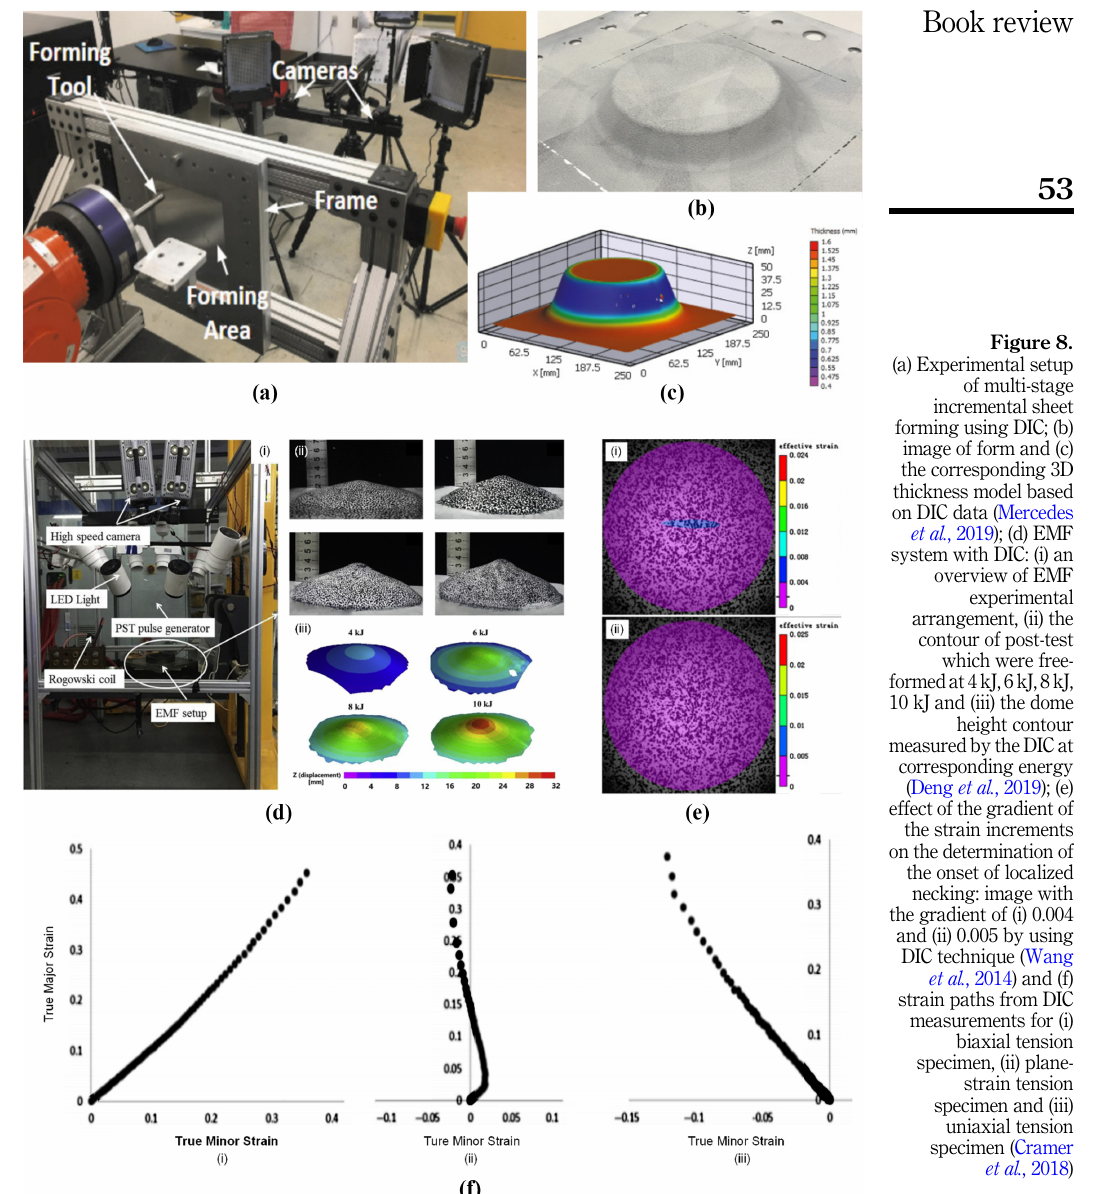
Figure 8. (a) Experimental setup of multi-stage incremental sheet forming using DIC; (b) image of form and (c) the corresponding 3D thickness model based on DIC data (Mercedes et al. , 2019); (d) EMF system with DIC: (i) an overview of EMF experimental arrangement, (ii) the contour of post-test which were free- formedat4kJ,6kJ,8kJ, 10 kJ and (iii) the dome height contour measuredby the DIC at corresponding energy (Deng et al. , 2019); (e) effect of the gradient of the strain increments on the determination of the onset of localized necking: image with the gradient of (i) 0.004 and (ii) 0.005 by using DIC technique (Wang et al. , 2014) and (f) strain paths from DIC measurements for (i) biaxial tension specimen, (ii) plane- strain tension specimen and (iii) uniaxial tension specimen (Cramer et al. ,